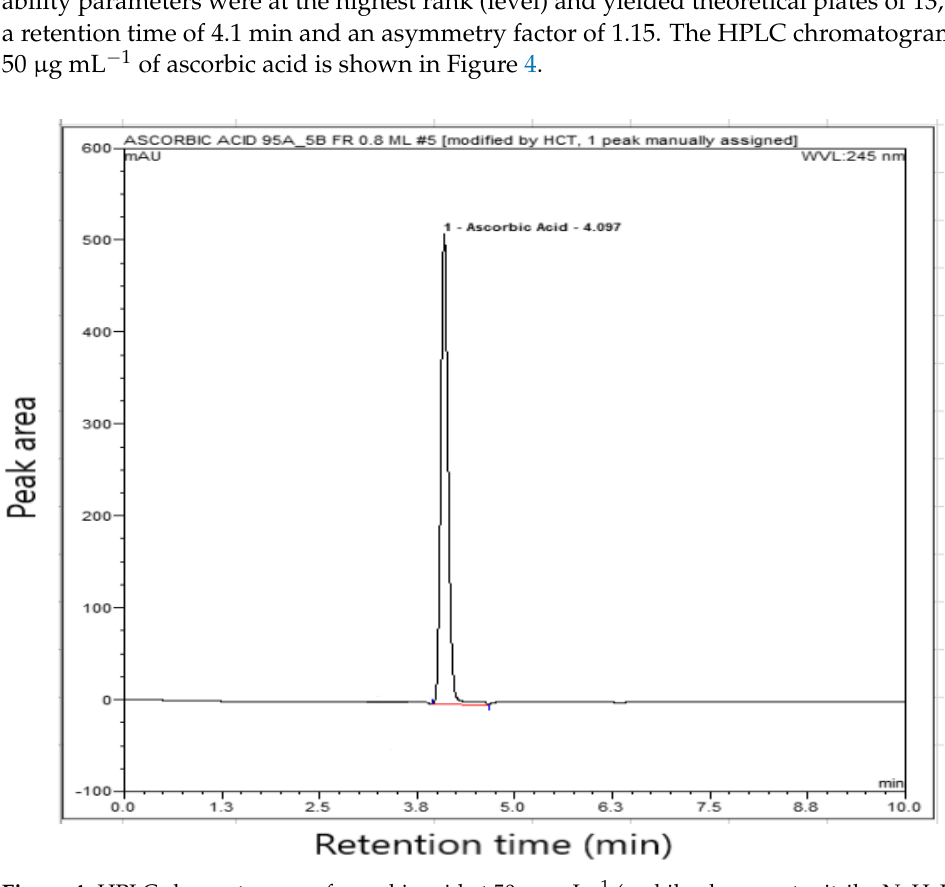
Figure 4. HPLC chromatogram of ascorbic acid at 50 µ g mL − 1 (mobile phase-acetonitrile: NaH 2 PO 4 - H 3 PO 4 buffer solution (pH = 3) (5:95 v / v ).